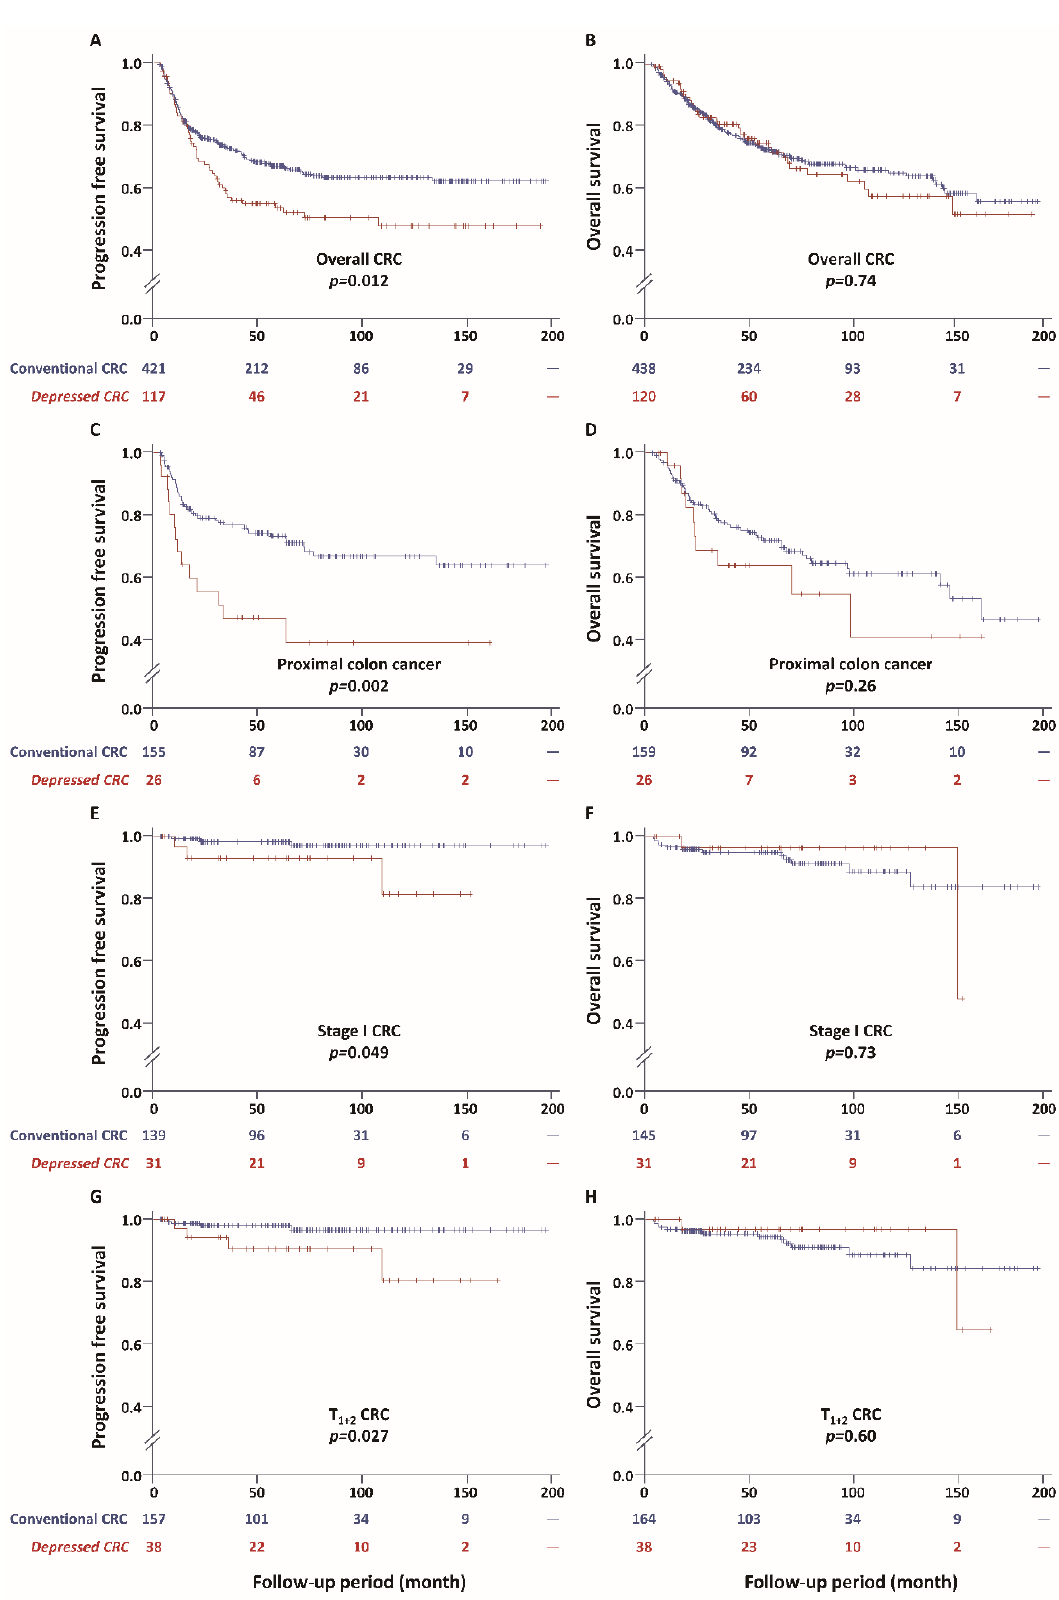
Figure 2. Depressed CRC associated with unfavorable survival compared with conventional CRC. The depressed CRC has an unfavorable progression-free survival (PFS) in comparison with the conventional CRC in overall CRC ( A ), proximal colon ( C ), early-stage (stage I) CRC ( E ), and small-sized cancer (T 1 + 2 cancer) ( G ). The overall survival (OS) is not significantly di ff erent between depressed CRC and conventional CRC with regard to overall ( B ), proximal ( D ), stage I ( F ), and T 1 + 2 cancers ( H